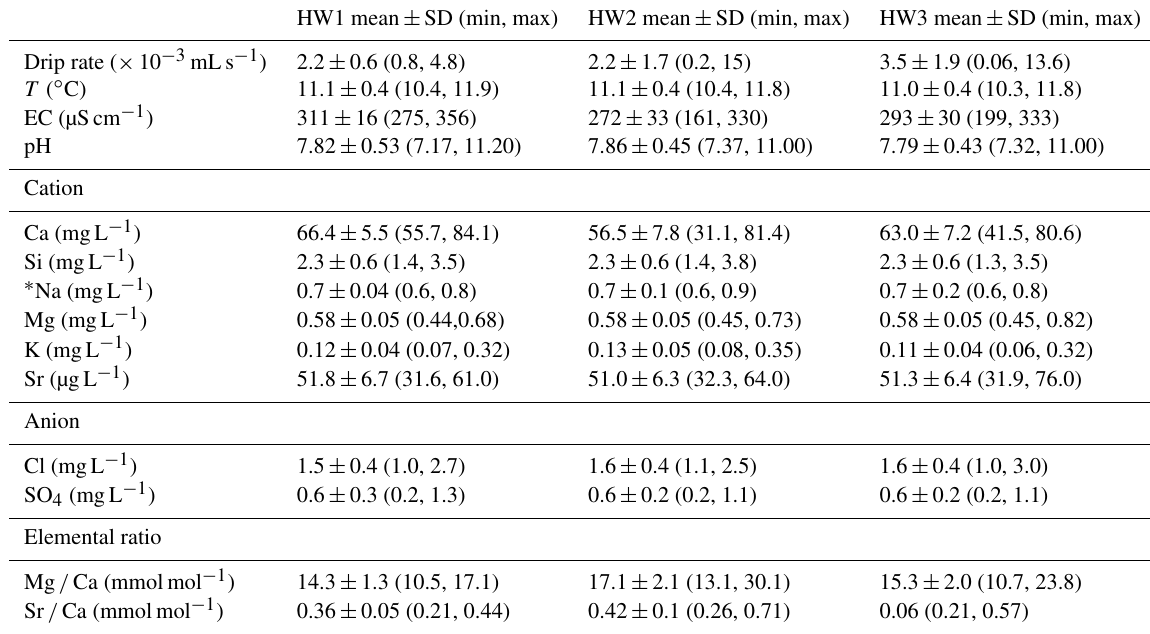
Table 3. Summary statistics of dominant ions in fortnightly drip-water samples analysed between 2006 and